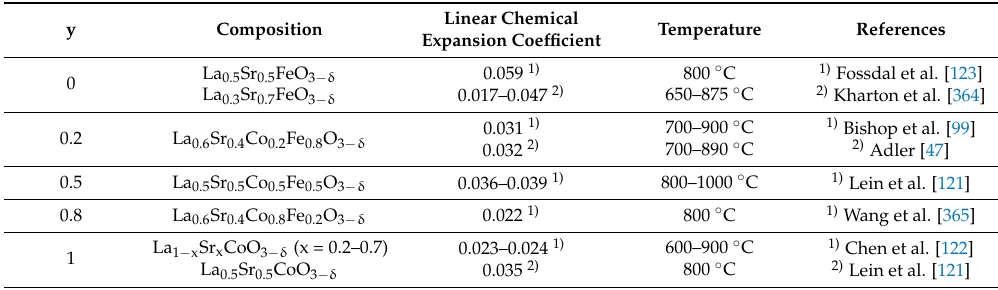
Table 10. Linear chemical expansion coefficients upon reduction, β red , for La 1 − x Sr x Co y Fe 1 − y O 3 − δ (LSCF) in the order of increasing Co-content